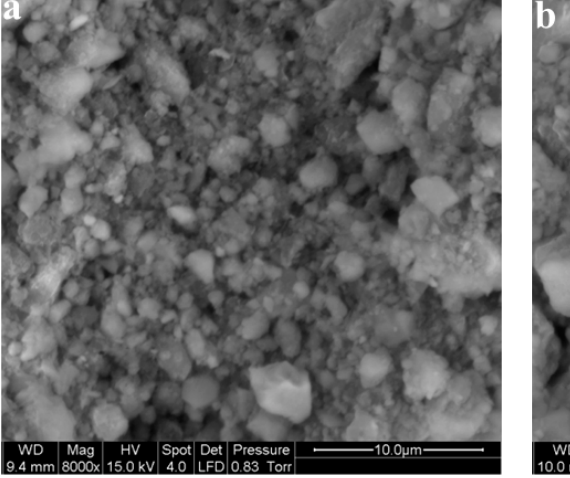
Figure 4. SEM images of solid stone coal. ( a ) Initial stone coal sample; ( b ) stone coal in Bioreactor after six cycle operation; ( c ) stone coal in Control 1 after six cycle operation; ( d ) stone coal in Control 2 after six cycle operation.